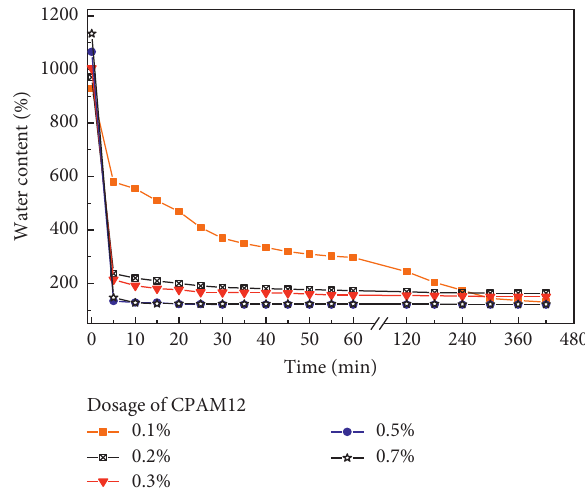
Figure 4: Water content curves of sediment with time after adding